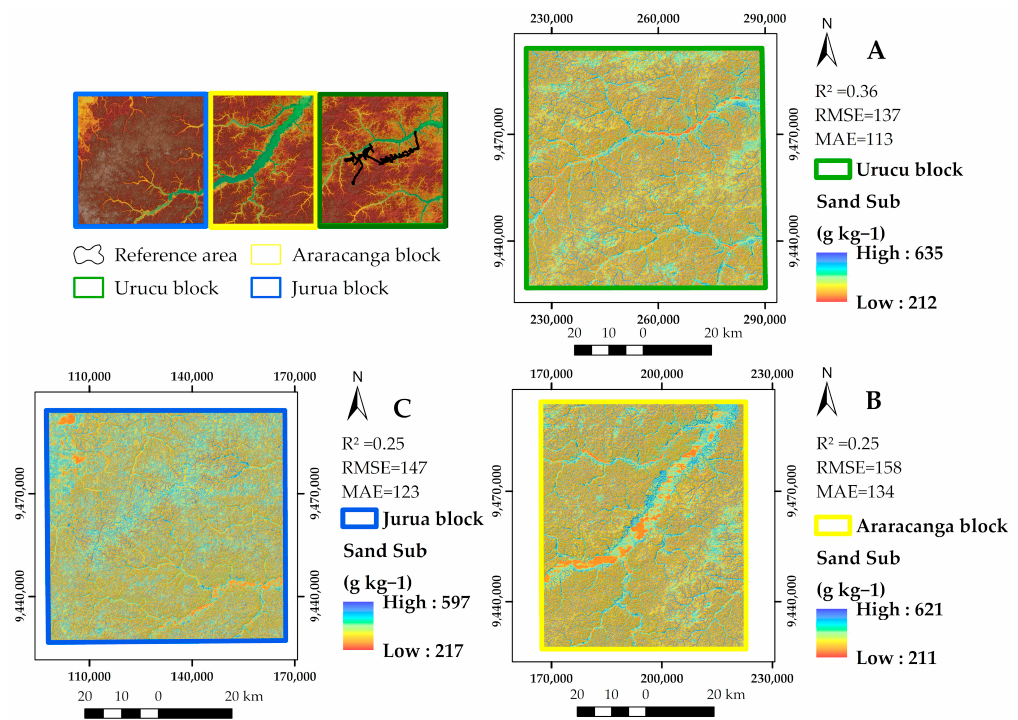
Figure 10. Map of the sand content at the subsurface layer. (Map generated using the Reference Area sampling design, Random Forest, and Wrapper Method), ( A ) Urucu block, ( B ) Araracanga block, ( C ) Jurua